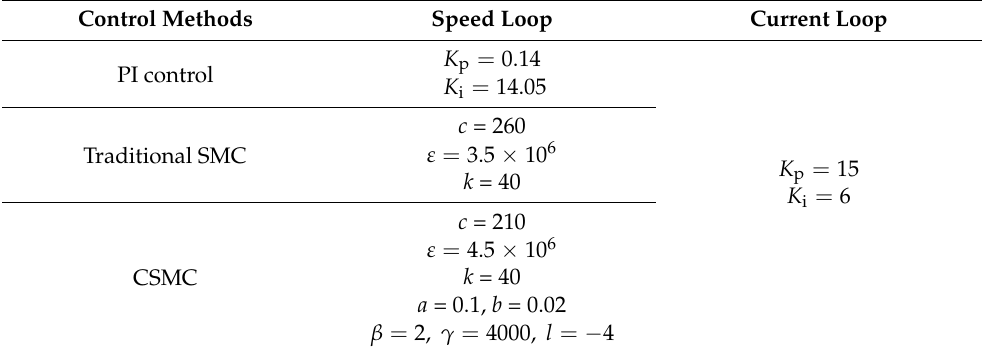
Table 2. Gain parameters of three control methods.